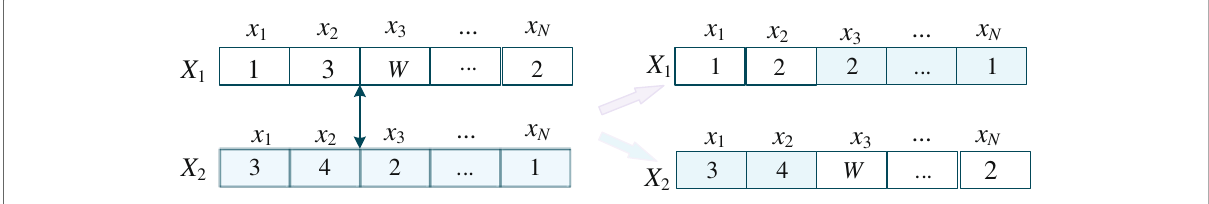
Fig. 3 An example of crossover